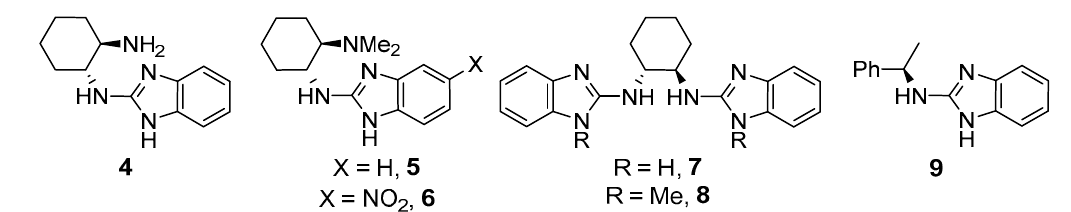
Figure 2. Benzimidazole-derived organocatalysts tested.